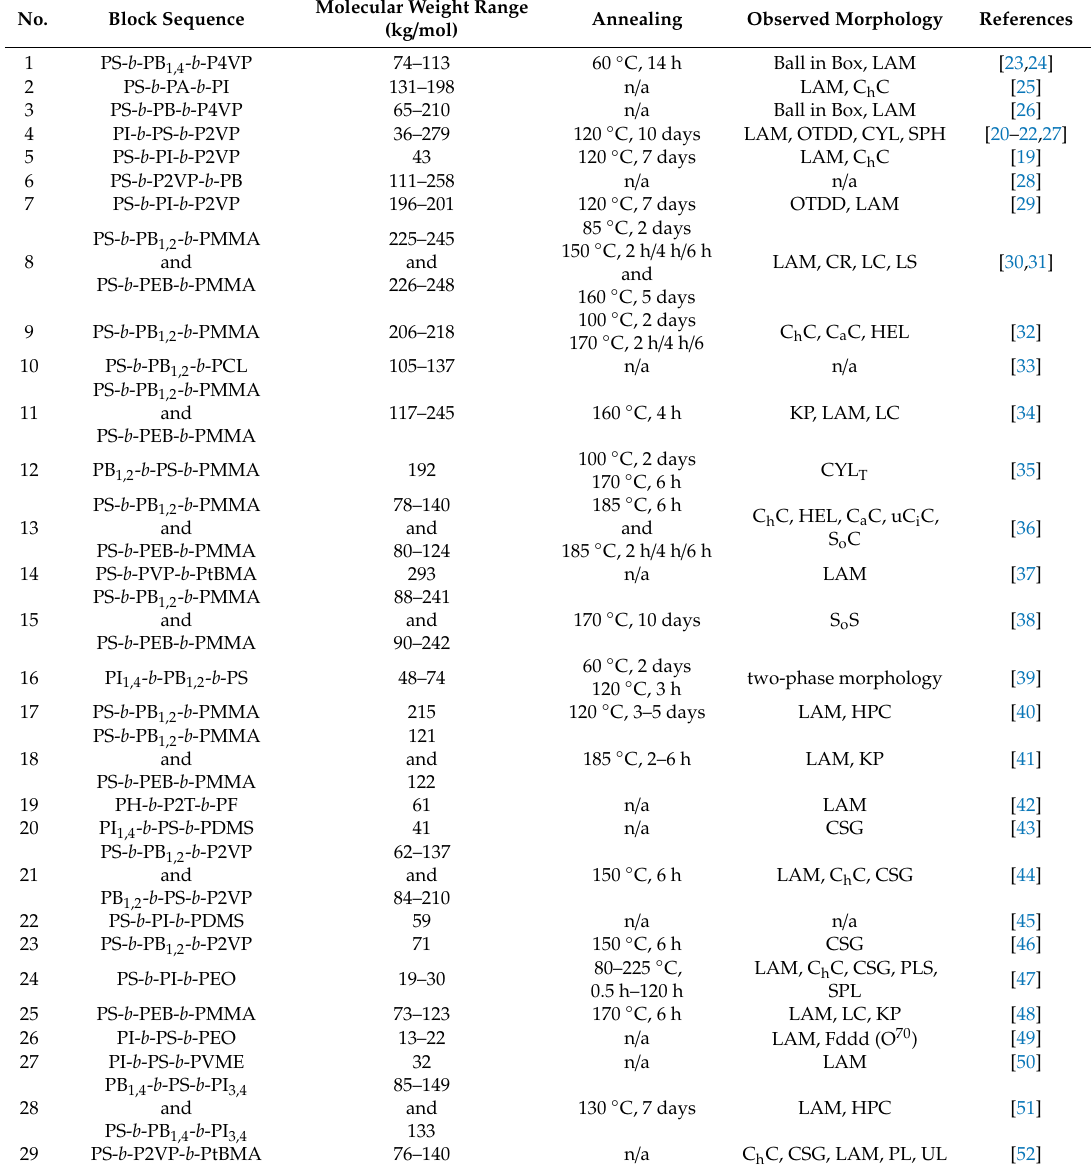
Table 1. Linear triblock terpolymer block sequences studied in the literature [23–74]. The total number average molecular weight range is given, together with the annealing conditions (if any) and the observed morphologies, in all